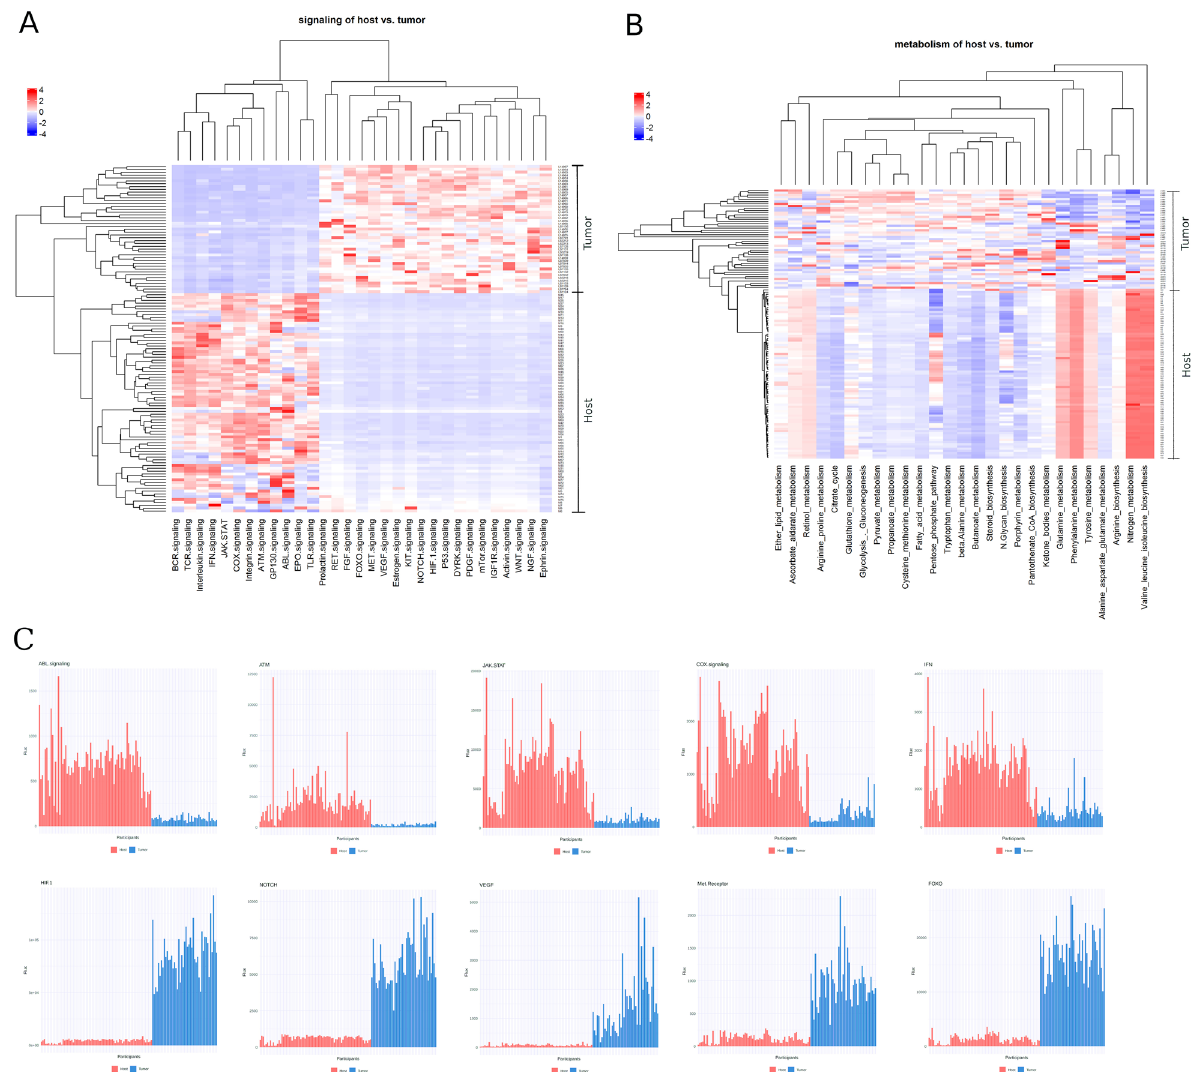
comparison between host- and